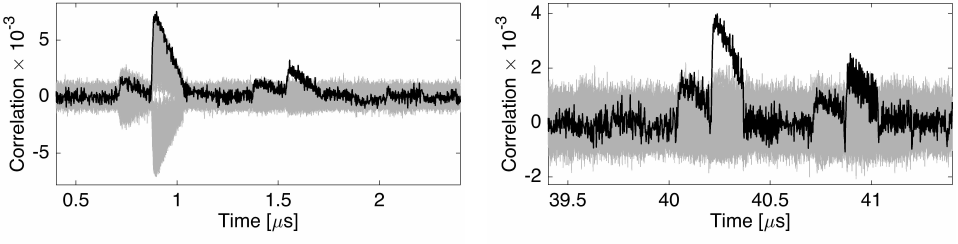
Figure 9: Experimental analysis of our AES encryption